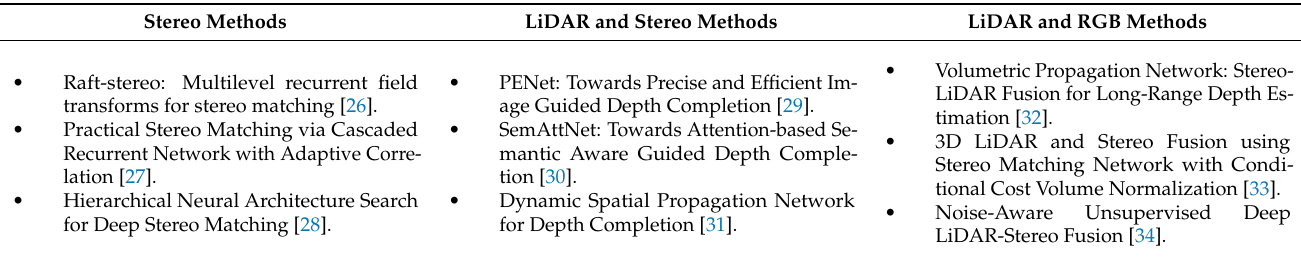
Table 1. The methods categorised by the input data